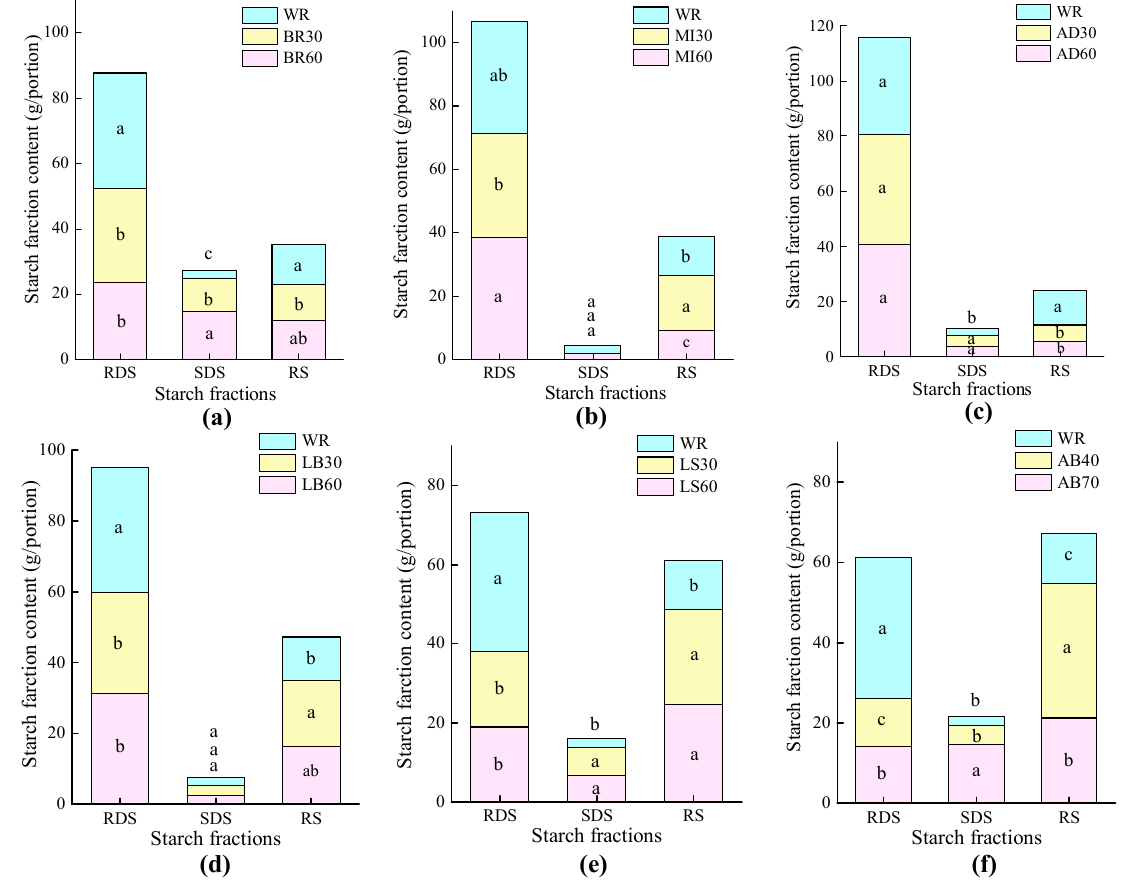
Figure 4. The constituents of starch fractions of test foods (Mean values with their standard deviations, n = 6). RDS, rapidly digestible starch; SDS, slowly digestible starch; RS, resistant starch; WR, white rice cooked for 30 min; ( a ) BR30 and BR60, waxy black rice cooked for 30 and 60 min; ( b ) MI30 and MI60, millet cooked for 30 and 60 min; ( c ) AD30 and AD60, adlay cooked for 30 and 60 min; ( d ) LB30 and LB60, dried lily bulb cooked for 30 and 60 min; ( e ) LS30 and LS60, lotus seed cooked for 30 and 60 min; ( f ) AB40 and AB70 adzuki bean cooked for 40 and 70 min. Differences of RDS, SDS, and RS between test foods and white rice are shown with unlike superscript letters, a,b,c ( p < 0.05).